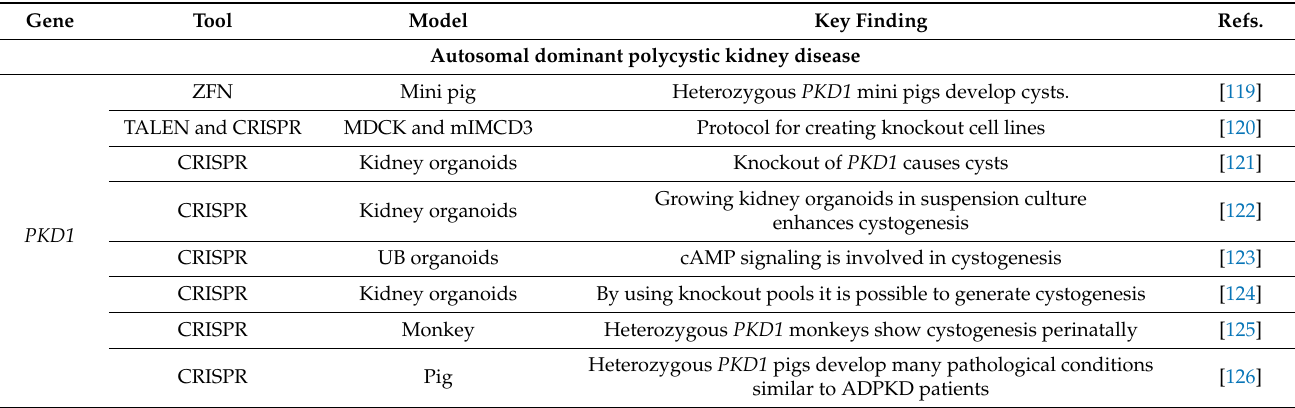
Table 3. Use of site-specific nuclease systems in Genetic kidney diseases